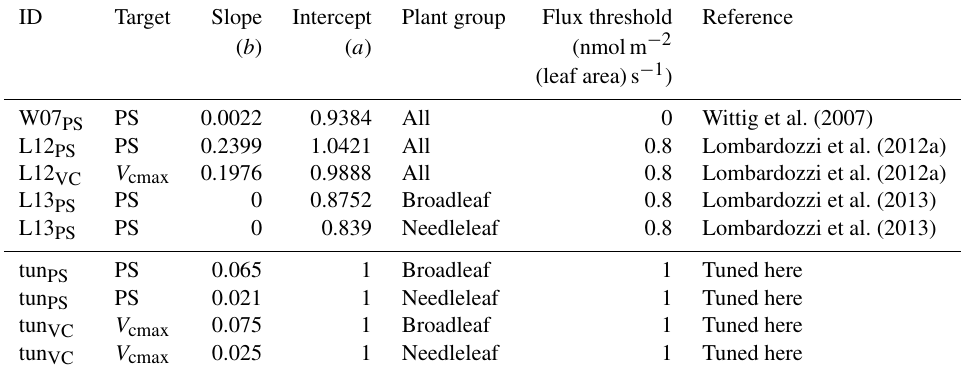
Table 1. Slopes and intercepts, partly PFT specific, of all four published (W07 PS , L12 PS , L12 VC , L13 PS ) and two tuned (tun PS , tun VC ) injury functions included in O-CN. Targets of ozone injury are net photosynthesis (PS) or V cmax . Injury calculations base on the CUOY with a specific flux threshold for each injury